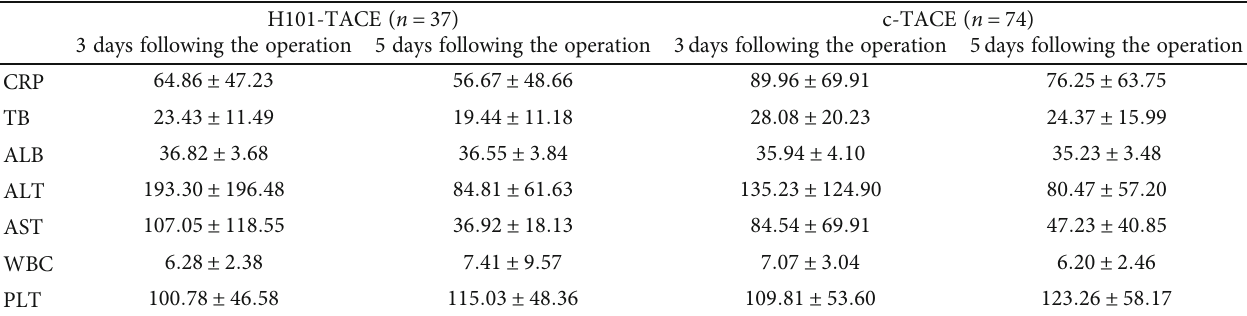
Table 5: The changes in blood routine and liver function between the two cohorts following operation. H101-TACE ( n = 37 ) c-TACE ( n = 74 ) CRP